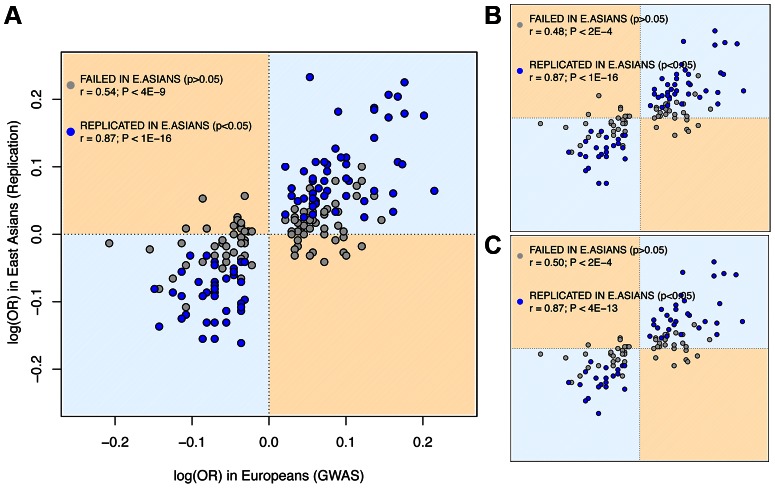
East Asian GWAS find the same risk allele and similar log(OR) than European discovery GWAS.
X axis: log(OR) for the replication stage of the discovery European GWAS. Y axis: log(OR) for the initial stage of East Asian GWAS (Materials and Methods). Dots in blue indicate significant (P<0.05) replication attempts in East Asia; dots in grey indicate non-significant replication attempts. (A) Using all replication attempts; (B) Using only the most-powered replication attempt per SNP; (C) Using the most-powered replication attempt per region. Attempts correspondent to SNPs with MAF<0.01 in East Asians are not shown.